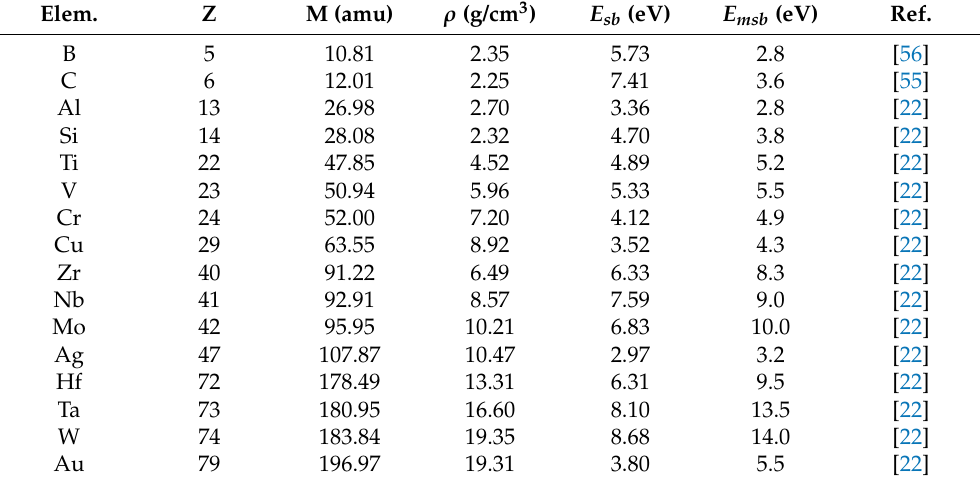
Table 1. Parameters used for SRIM simulations. Z —atomic number, M —atomic mass, ρ —mass density, E sb —surface binding energy used in SRIM (i.e., the heat of sublimation), E msb —modified surface binding energy. References point to the experimental data that were used for simulation of the total sputtering yield from which the modified surface binding energy was obtained.